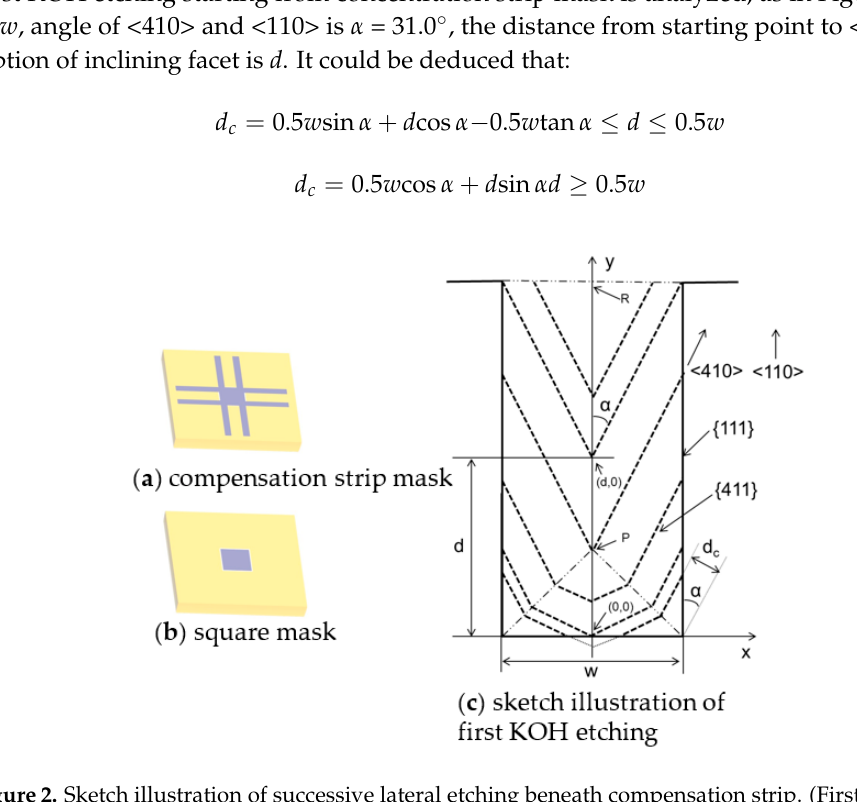
Figure 2. Sketch illustration of successive lateral etching beneath compensation strip. (First KOH etching).